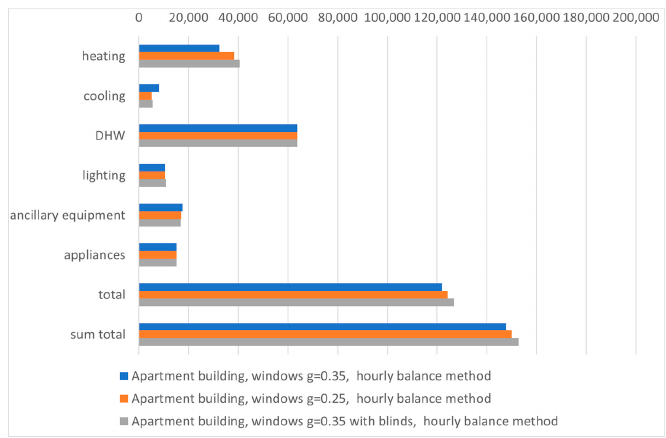
Figure 16. The primary energy demand of glazings and windows with and without solar blinds for the office building. Figures 17 and 18 show that differences in total final energy demand reached several percentage points, both for the office and residential building. This means that neither of the alternatives under analysis negatively affected the building’s energy performance in its basic version. The differences in final energy demand between the assumed alterna- tives in the office and residential buildings were at a similar level, which means that there was no need to perform costly glazing replacement during the process of changing the form of use from office use to residential use.